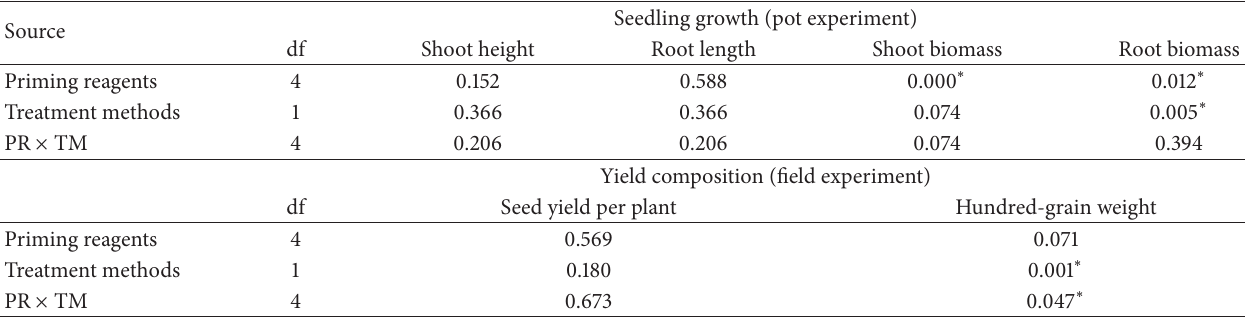
Table 1: Analysis of variance for seed priming effects on maize for seedling growth and yield composition ( 𝑛 = 10 , 𝑃 < 0.05 ).